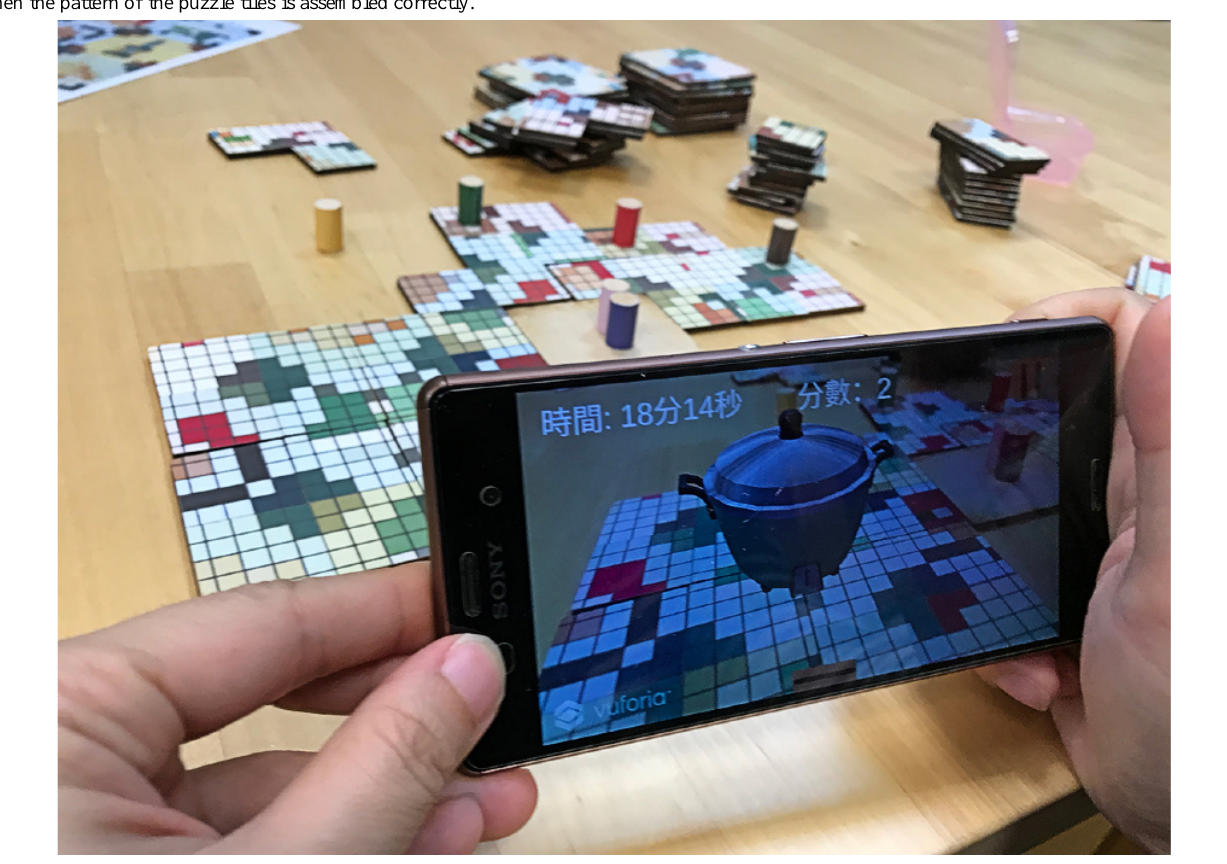
Figure 4. The three-dimensional object of one of the nostalgic artifacts, an automatic cooker and steamer, is presented on the screen of a mobile device when the pattern of the puzzle tiles is assembled